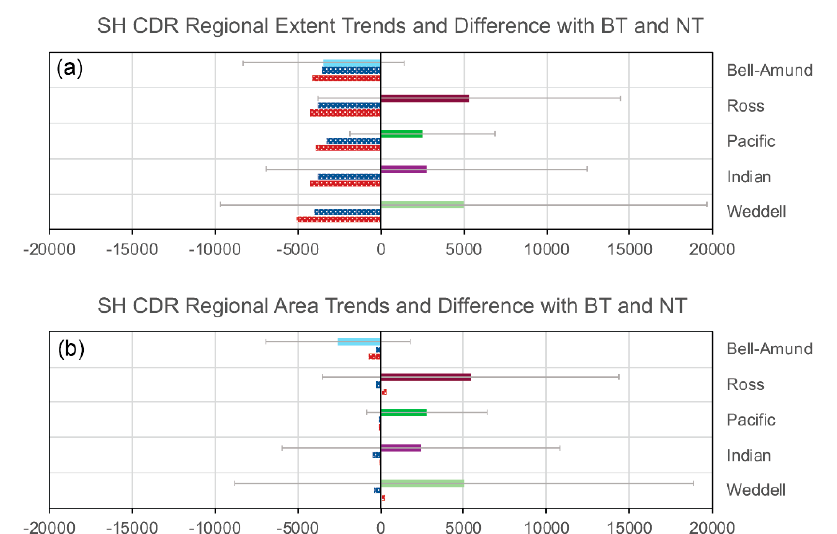
Figure 7. Southern Hemisphere regional ( a ) extent and ( b ) area trends in km 2 yr − 1 . Solid color bars correspond to the region colors in Figure 5. The gray error bars represent the 2 standard deviation range of the linear trend fit. The blue hatched bar for each region indicates the CDR-BT trend and the red hatched bar indicates the CDR-NT trend.